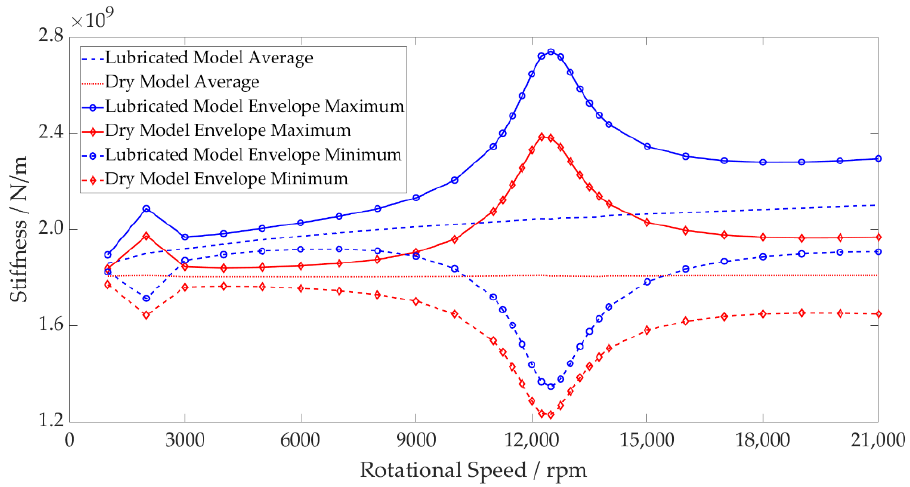
Figure 9. Inner Race Stiffness — Dry vs. Lubricated Operating Envelope.